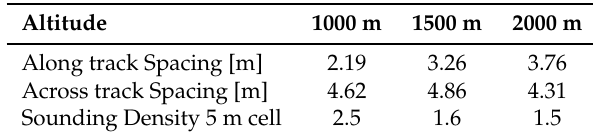
Table 19. Along and across track resolutions for EM 304 2 × 4, 1000, 1500, 2000 m, and swath limited to 2 km.